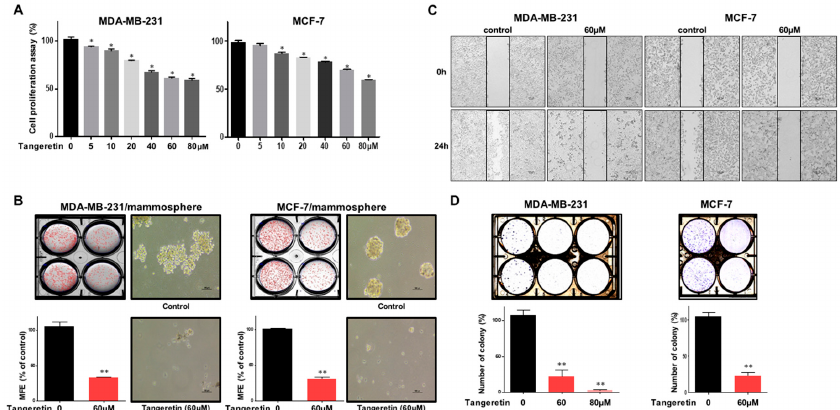
Figure 3. The effects of tangeretin on cell proliferation and mammosphere formation. ( A ) MDA-MB-231 and MCF-7 cells were treated with tangeretin for 24 h in a medium supplemented with 10% FBS. The cytotoxicity of tangeretin was measured with an EZ-Cytox kit. ( B ) Tangeretin inhibits the formation